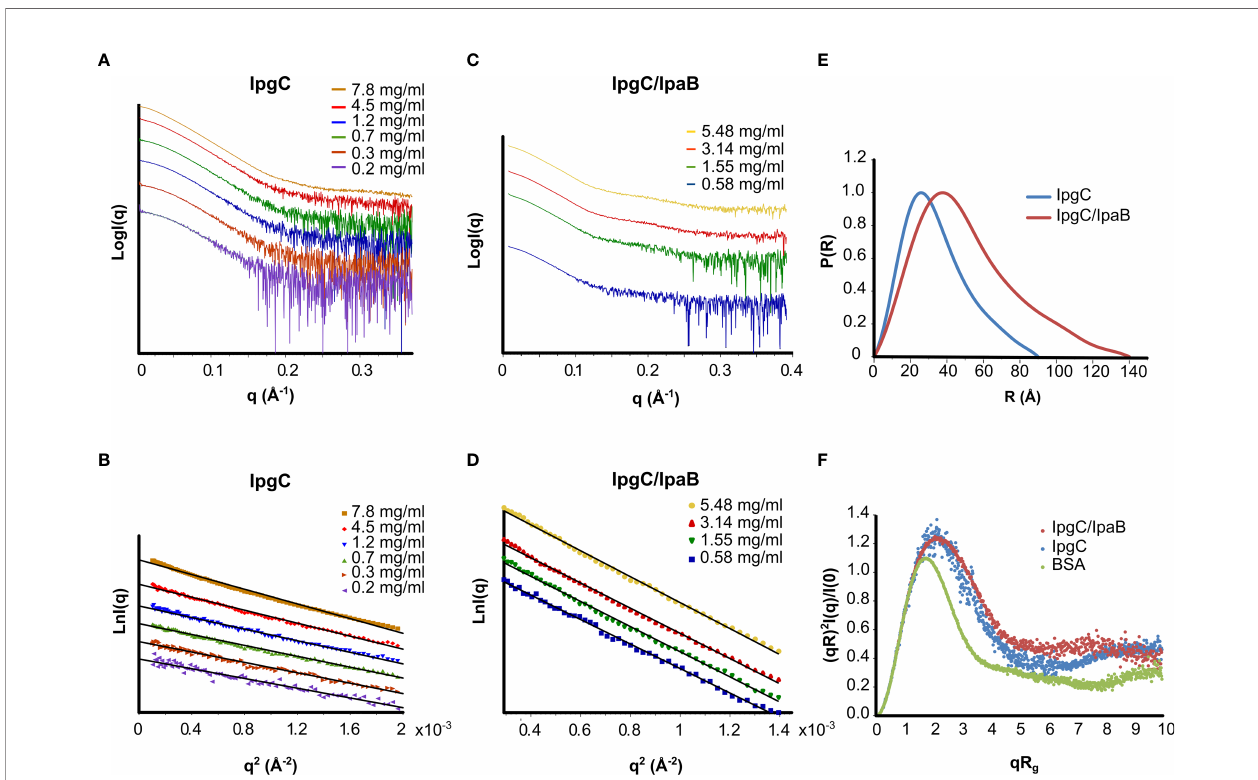
FIGURE 3 | SAXS analysis of the IpgC (A, B, E, F) and IpgC/IpaB complex (C – F) . (A, C) SAXS Intensity pro fi les (in logarithmic scale) for six concentrations of IpgC (A) and four concentrations of the IpgC/IpaB complex (C) . (B, D) Guinier plots linearity indicates monodispersity for the IpgC/IpaB complex (D) and aggregation for the higher concentrations of IpgC (B) . (E) Normalized pair distance distribution functions P(r) for IpgC and IpgC/IpaB. (F) Normalized Kratky plots of IpgC and the IpgC/IpaB complex (a globular, well folder protein, BSA, is also shown for